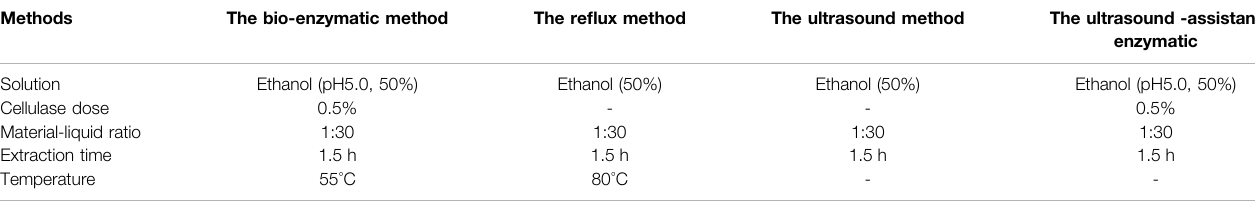
TABLE 1 | Conditions of four extraction methods.